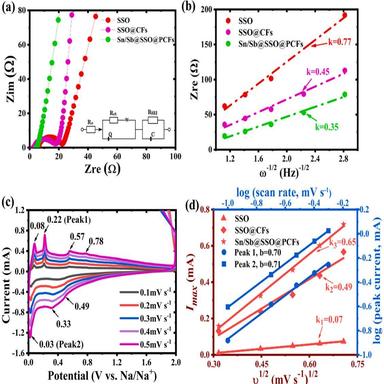
(a) Compare of the EIS spectra for different samples. (b) Fitting plots of Zre and ω−1/2 in the frequency range of 0.1–1.0 Hz. (c) CV curves of the Sn/Sb@SSO@PCFs anode at varied scan rates: 0.1, 0.2, 0.3, 0.4 and 0.5 mV s−1. (d) Relationship between peak current and sample scanning rate, and utilizing the link between peak current and scan rate to determine the b value.